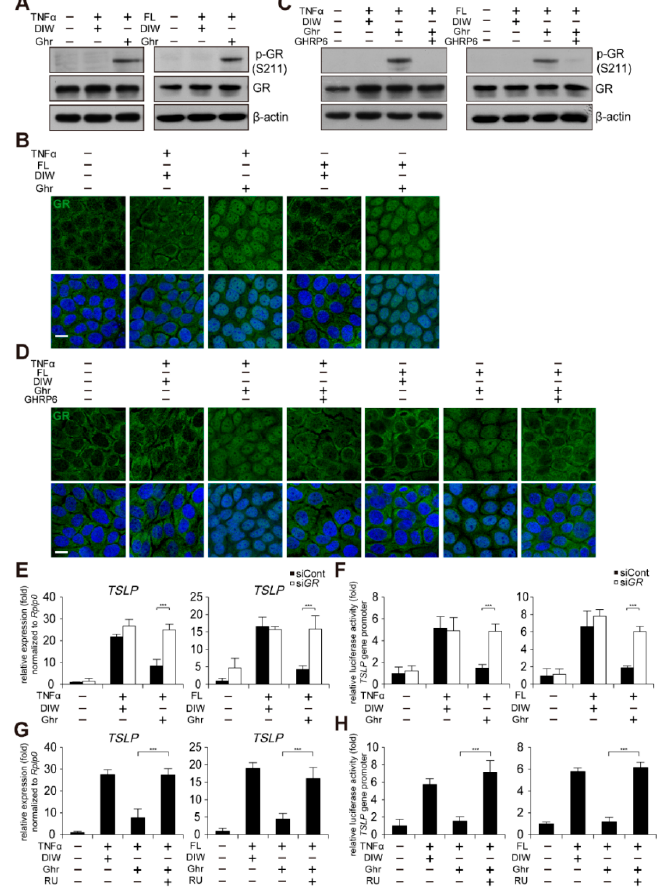
Figure 4. Ghrelin suppresses TSLP gene activation through GR activation. ( A ) Ghrelin induces phosphorylation of GR (S211) in HaCaT keratinocytes treated with TNF α or bacterial flagellin (FL). HaCaT keratinocyte lysates were immunoblotted with anti-GR, anti-phospho GR (S211), and anti- β - actin antibodies ( n = 3). β -actin was used as a control. DIW was used as solvent for TNF α , flagellin, ghrelin, and GHRP6. Representative images are shown. ( B ) Ghrelin induces nuclear translocation of GR in HaCaT keratinocytes treated with TNF α or bacterial flagellin. HaCaT keratinocytes were immunostained with anti-GR antibody ( n = 3) (top panel). DAPI was used for nuclei staining (low panel). Scale bar, 10 µ m. Representative images are shown. ( C ) GHRP6 abolishes ghrelin-induced phosphorylation of GR (S211) in HaCaT keratinocytes treated with TNF α or bacterial flagellin. HaCaT keratinocyte lysates were immunoblotted with anti-GR, anti-phospho GR (S211), or anti- β - actin antibodies ( n = 3). Representative images are shown. ( D ) GHRP6 abolishes ghrelin-induced nuclear translocation of GR in HaCaT keratinocytes treated with TNF α or bacterial flagellin. HaCaT keratinocytes were immunostained with anti-GR antibody ( n = 3) (top panel). DAPI was used for nuclei staining (low panel). Scale bar, 10 µ m. Representative images are shown. ( E , F ) Depletion of GR by siRNA abolishes ghrelin-induced suppression of TSLP gene activation in HaCaT keratinocytes treated with TNF α or bacterial flagellin. Real-time PCR was performed to quantify TSLP and RPLP0 transcripts ( n = 3). RPLP0 was used as a control. After HaCaT keratinocytes were transiently transfected with luciferase reporter vector containing the TSLP gene promoter and control Renilla luciferase expression vector, luciferase activity was measured ( n = 3). ( G , H ) RU486 (RU), a GR antagonist, abolishes ghrelin-induced suppression of TSLP gene activation in HaCaT keratinocytes treated with TNF α or bacterial flagellin. Real-time PCR was performed to quantify TSLP and RPLP0 transcripts ( n = 3). After HaCaT keratinocytes were transiently transfected with luciferase reporter vector containing the TSLP gene promoter and control Renilla luciferase expression vector, luciferase activity was measured ( n = 3). All data represent mean ± S.E.M. Significance value was *** p ≤